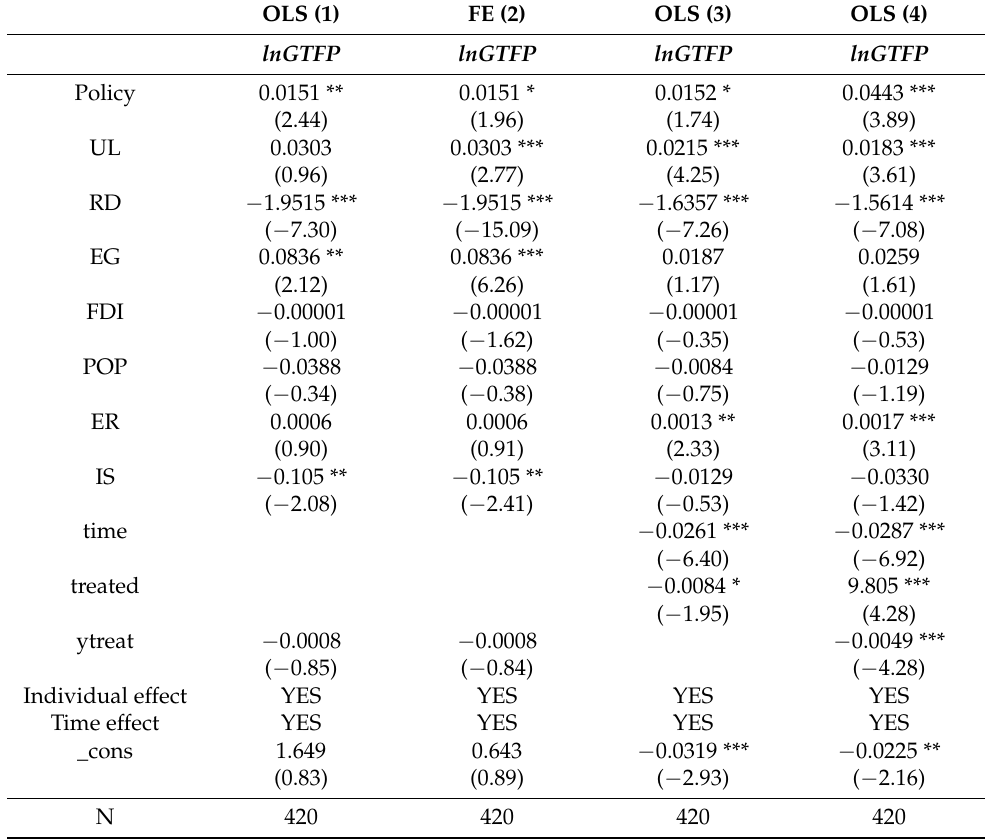
Table 3. Parameter estimation results of the benchmark